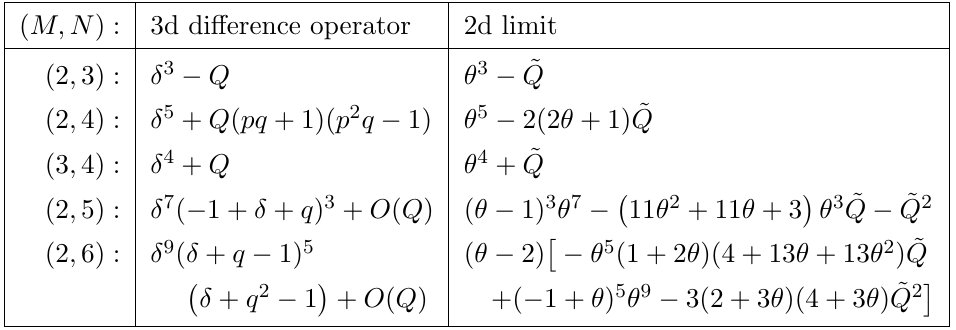
Table 1 . Di(cid:11)erence operators for low values of ( M; N ) and their 2d